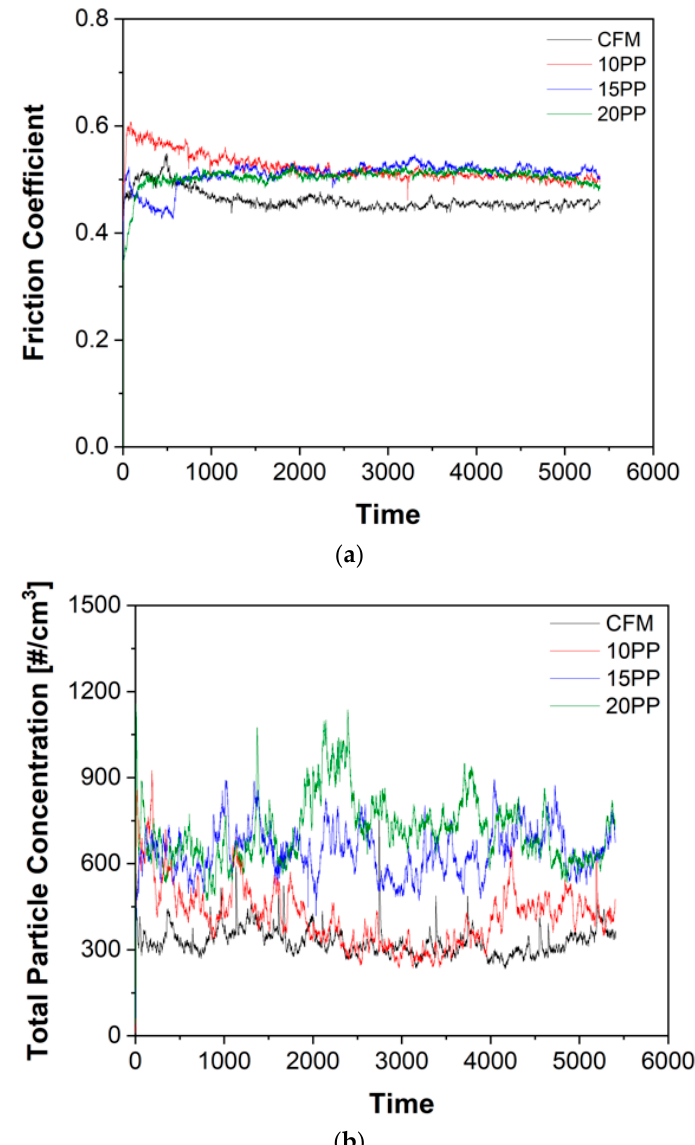
Figure 6. ( a ) CoF traces; ( b ) emission traces of reference CFM and with PP waste addition.